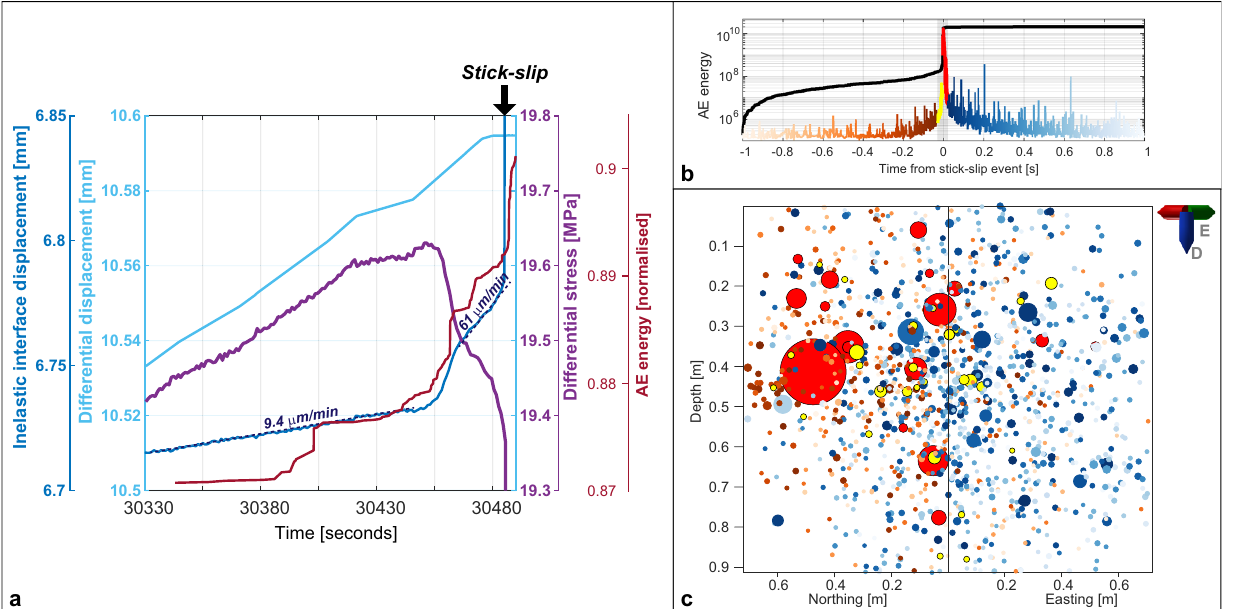
Figure 6. Evolution of stick–slip event. ( a ) Inelastic and differential interface displacements show an acceleration phase of the inelastic displacement only 10 s before the initiation of the stick–slip event. Differential stresses start to decrease about 30 s before the stick–slip, and continue to decrease also during the last 10 s before the stick–slip, even at constant differential displacement, expressing slip-weakening behavior of the interface. ( b ) Stacked AE-energy plotted along 2 s centered around the main-shock of the stick–slip event. Y-axis is logarithmic in scale and shows increase of about 5 orders of magnitude in AE-energy from noise level 1 s before the stick–slip and the main shock. Note that the energy level after the stick–slip is generally higher than before. Applied colorcode is also valid to individual events located along the interface in ( c ), showing temporal evolution of events along the interface, indicating movement from one to the other side. The size of the circles relates to the energy of the events in logarithmic